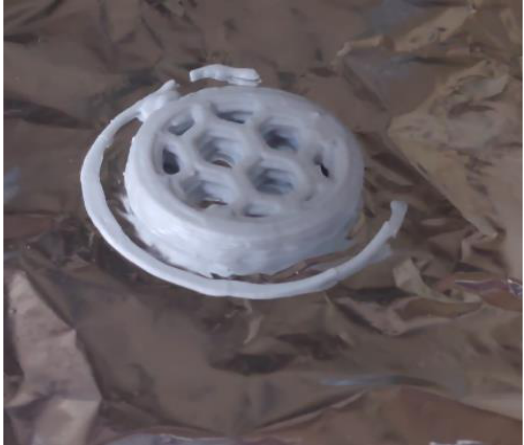
Figure 2. Sample after extrusion 3D-printing prepared from highly concentrated hardening suspensions (Ca(PO 3 ) 2 /Ca 2 P 2 O 7 =0/100)